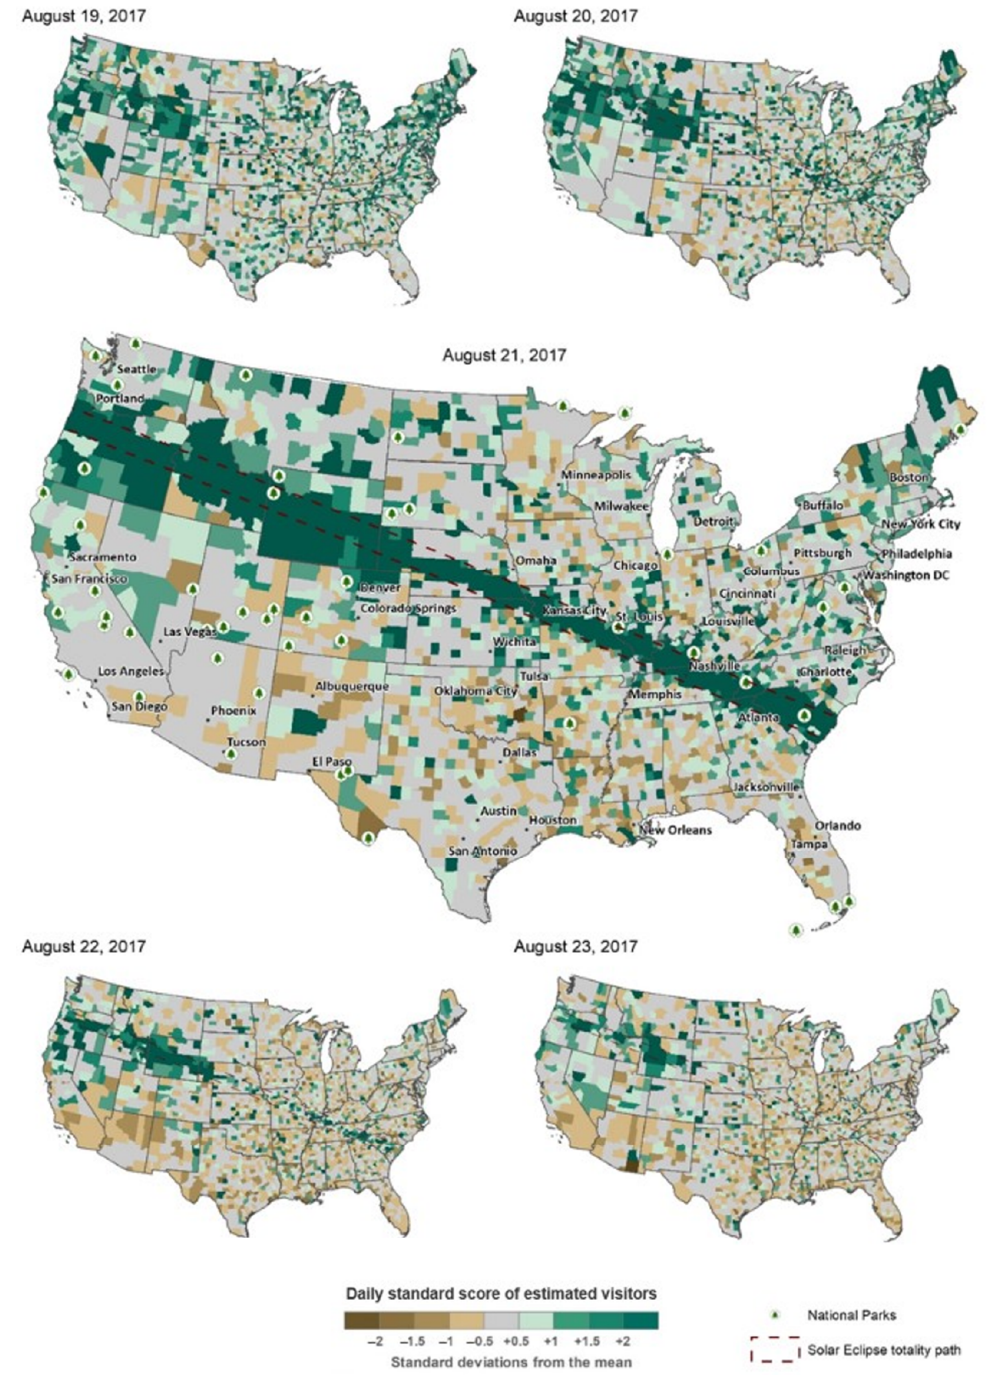
Figure 6. Daily standard score of estimated visitors from 19 August to 23 August 2017 for the contiguous US.